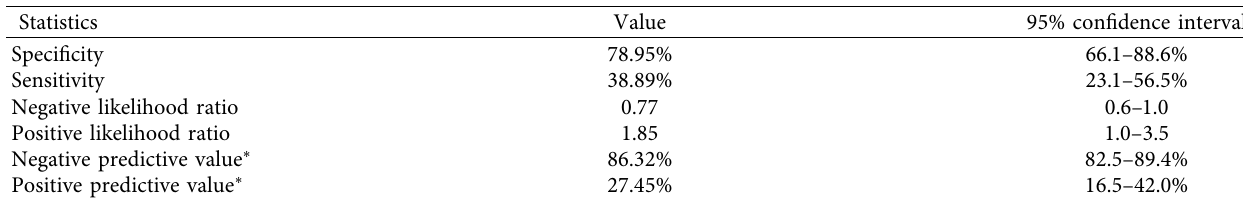
Table 2: Statistical analysis of intraluminal gas in predicting gangrenous